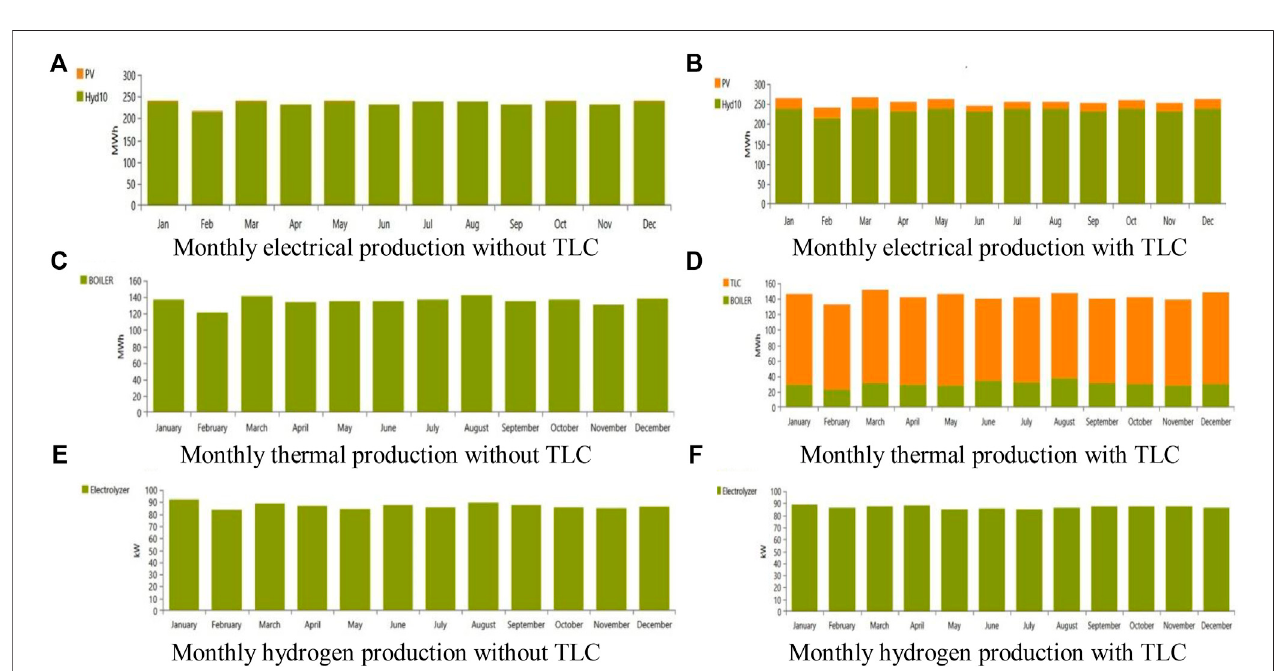
FIGURE 7 | Monthly energy productions. (A) Monthly electrical production (with and without TLC). (B) Monthly thermal production (without TLC). (C) Monthly thermal production (with TLC). (D) Monthly hydrogen production (with and without